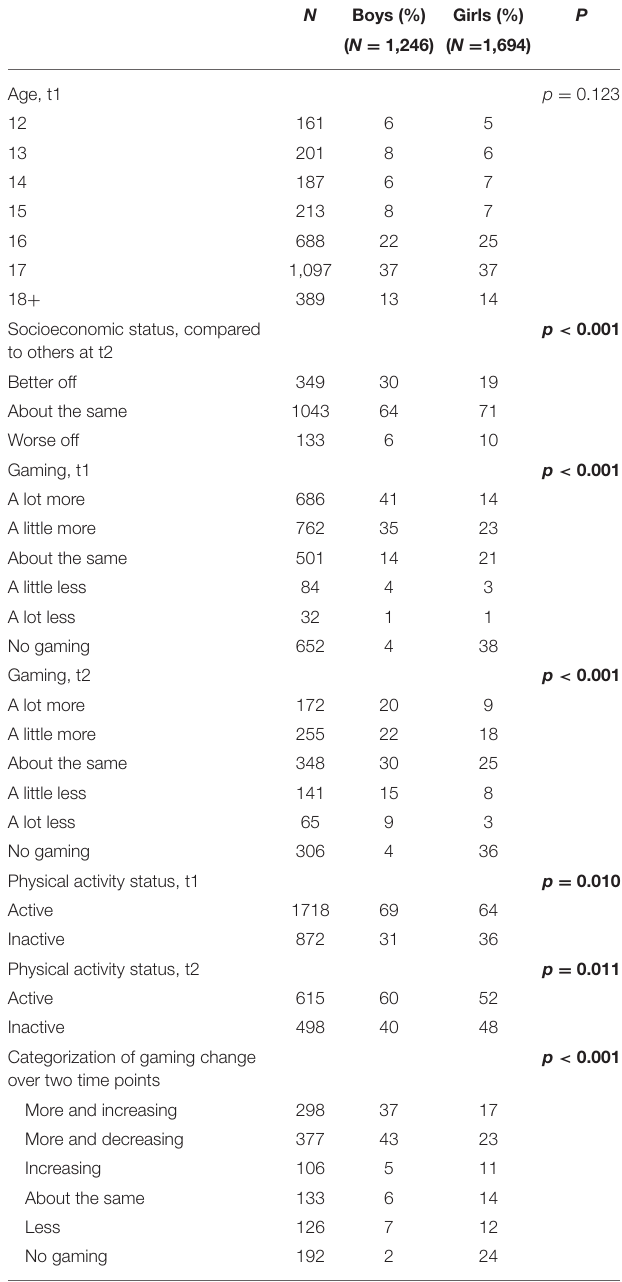
Bold indicates significant differences between groups, based on χ 2